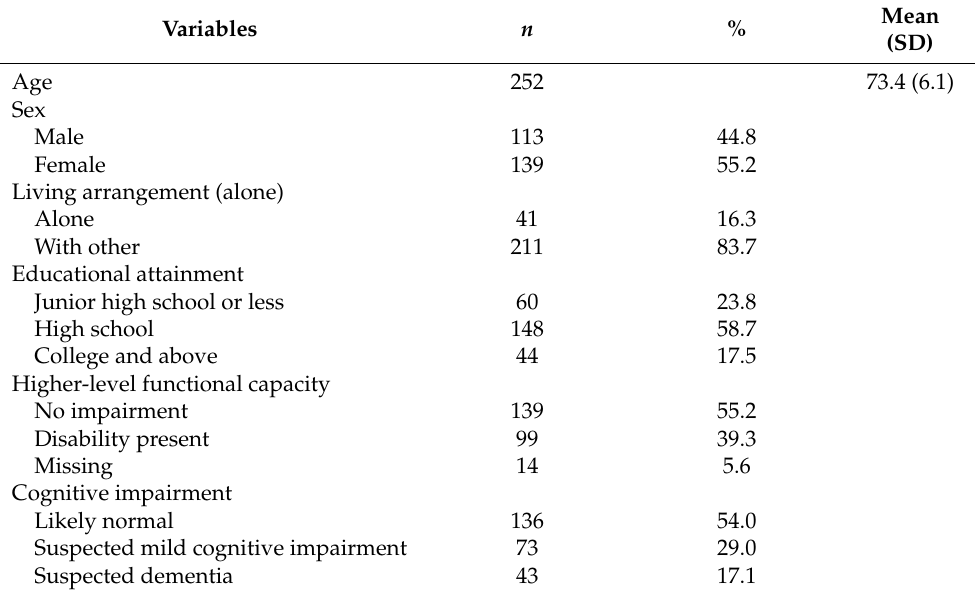
Table 1. Demographic and age-associated cognitive functional characteristics of the participants ( n =